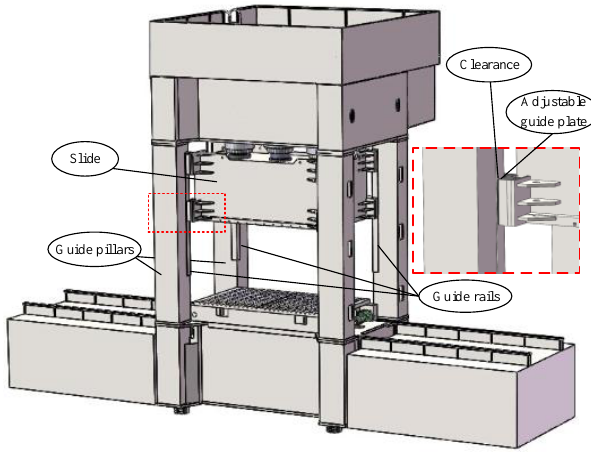
Figure 1. A hydraulic press. The inset shows the clearance between the slide and one of the pillars.